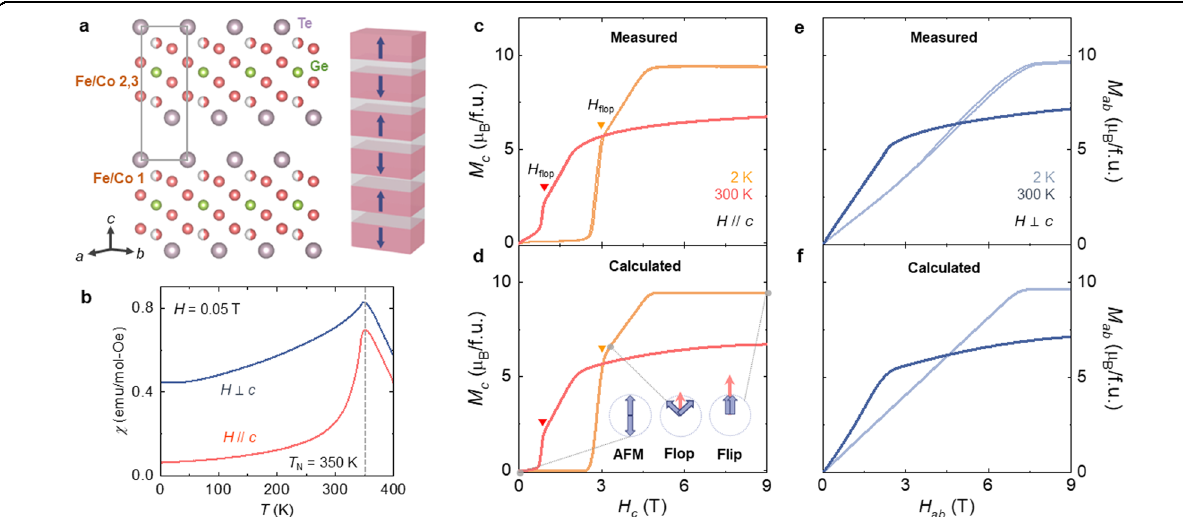
Fig. 1 High- T N antiferromagnetism of (Fe 0.54 Co 0.46 ) 5 GeTe 2 (FCGT). a Crystallographic structure of FCGT viewed along the [110] direction. The red, green, and light purple spheres indicate Fe/Co, Ge, and Te atoms, respectively. Fe/Co 1 sites are half- fi lled, whereas Fe/Co 2 and 3 sites are fully occupied. The gray rectangle designates a unit cell. The schematic depicts the formation of a multilayered magnetic structure, i.e., A-type antiferromagnetic order. b Magnetic susceptibility, χ = M / H , measured upon warming under H = 0.05 T after zero- fi eld cooling for H//c and H ⊥ c . The vertical dashed gray line speci fi es the Néel temperature, T N = 350 K. c Isothermal magnetization measured for H//c ( M c ) at T = 2 and 300 K. The red and orange inverted triangles denote the occurrence of spin- fl op transitions, H fl op = 2.8 and 0.8 T for T = 2 and 300 K, respectively. d Calculated M c for T = 2 and 300 K, estimated from a uniaxial anisotropic spin model. The schematics illustrate the angles of the magnetic moments (blue arrows) for the AFM, spin- fl op, and spin- fl ip states at T = 2 K. The red arrows correspond to the strength of H c . e Isothermal magnetization measured for H ⊥ c ( M ab ) at T = 2 and 300 K. f Calculated M ab for T = 2 and 300